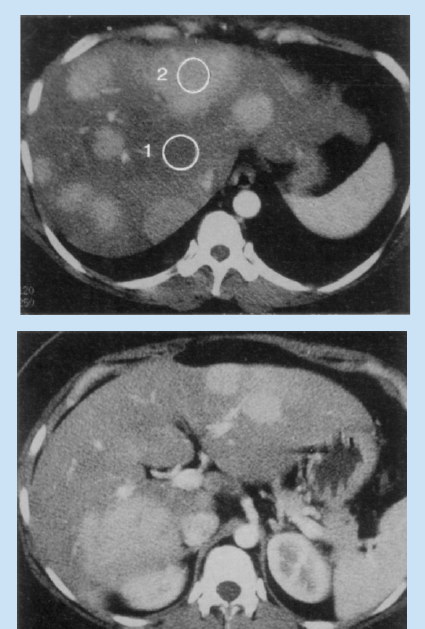
Fig. 2a and 2b. Contrast-enhanced CT in case 2 demonstrates multiple pseudolesions in both lobes from focal fatty sparing. Note that the nor- mally enhancing parenchyma measures 80 HU (region of interest 2) while the region of fatty infil- tration (region of interest 1) measures 15